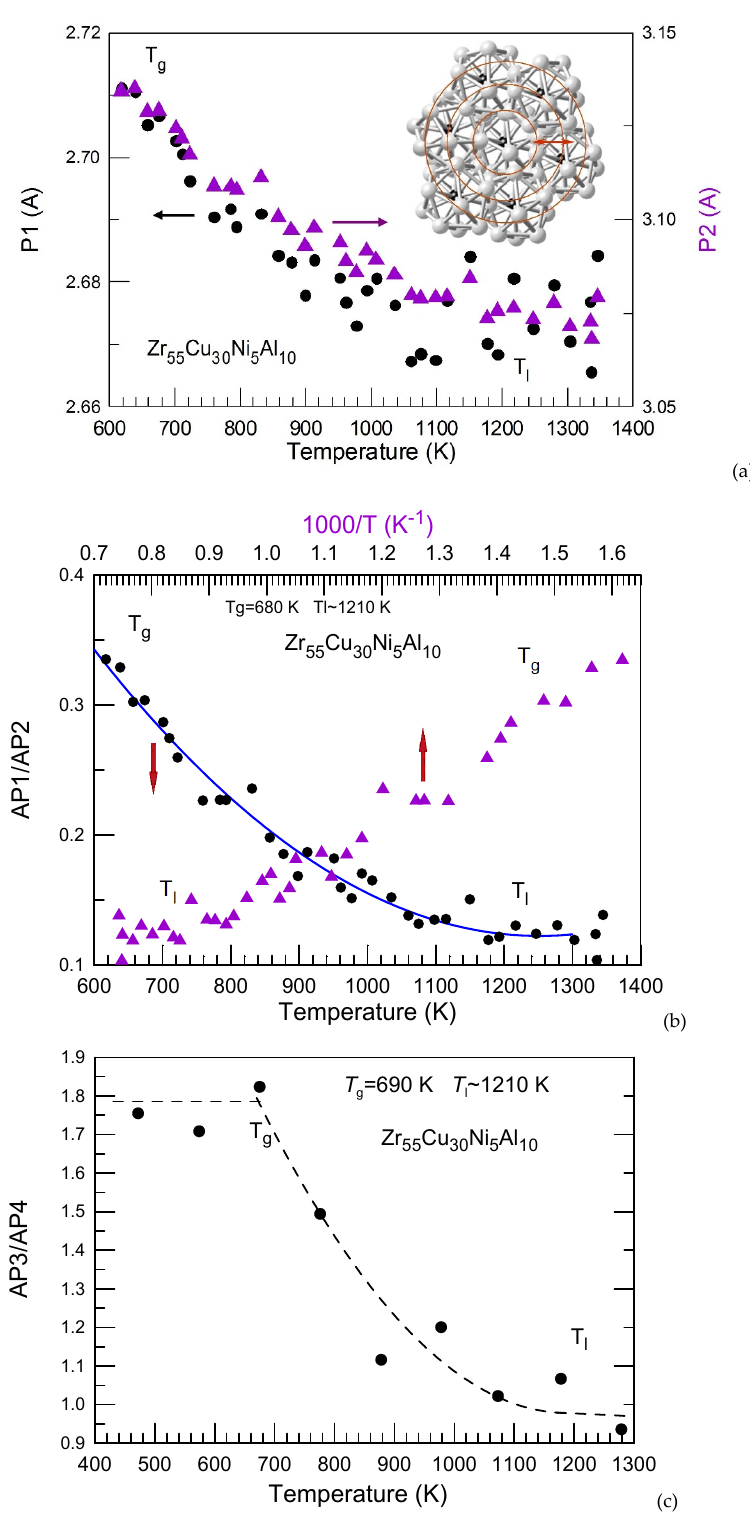
Figure 9. Positions of P1 and P2 in the first coordination shell ( a ) and the ratio of the corresponding peak areas ( AP1/AP2 ) ( b ) as a function of temperature ( a , b ) and inverse temperature in ( b ). The arrows in ( a ) indicate Y-axes corresponding to the data while the arrows in ( b ) indicate the corre- sponding X-axes. The insert in ( a ) is a schematic representation of atomic positions within and be- tween the first and higher order coordination shells indicated by red circles. The plots were repro- duced from Ref. [152] with permission of Elsevier. The area ratios AP 3/ AP 4 as a function of temper- ature ( c ) are calculated from G ( R ) functions from the earlier work [152]. The temperature dependence of the first two sub-peaks intensity ratio in the super- cooled liquid alloy follows variation of viscosity. It suggests that an increased chemical short range order due to formation of the atomic clusters is directly responsible for the rapid non-Arrhenius increase in viscosity of a supercooled liquid upon cooling. Continu- ous structural changes in the supercooled liquid leading to the formation of preferred atomic bonds in the first coordination shell and modification of medium range order both change the activation energy ( E a ) for viscous flow in Equation (2), and thus, cause devia- tion from the Arrhenius temperature dependence of viscosity which in term determines fragility of the glass-forming liquids. As in case of the Pd-Cu-Ni-P alloy [136] AP1/AP2 (the area under P1 divided by the area under P2) ratio changes on cooling in the supercooled liquid state. However, the changes in AP1/AP2 ratio for the Zr 55 Cu 30 Ni 5 Al 10 liquid alloy from T l to T g ( AP1/AP2 = 2.5) are smaller in the absolute values compared to those found in the Pd 40 Cu 30 Ni 10 P 20 liquid alloy for which AP1/AP2 = 4.5 [136]. The AP1/AP2 ratio values normalized per Kelvin ( APR n ) according to the supercooled liquid region on cooling ( T l – T g ) are 0.005 and 0.017 K –1 , respectively, are in line with a lower fragility of the Zr 55 Cu 30 Ni 5 Al 10 melt compared to that of the Pd 40 Cu 30 Ni 10 P 20 one. The difference in the specific heat capacity ( C p ) at T g between the liquid and glassy phases is also used to estimate fragility [161]. Δ C pl–g values (difference between C p of liquid ( C pl ) and glassy ( C pg ) phases) of 10 and 17 J/mol ⋅ K for Zr 55 Cu 30 Ni 5 Al 10 and Pd 42.5 Cu 30 Ni 7.5 P 20 alloys, respectively [152], are also in line with the fragility parameters of these alloys. Metallic glasses exhibiting more fragile supercooled liquid behavior showed a higher degree of density fluctuations probed using synchrotron X-ray nanoscale computed to- mography [138,162]. It was also proposed that there is a link between steepness of the repulsive part of the interatomic potential (derived from the shape of PDF ( R )) and rate at which shear modulus decreases with temperature [163]. This mechanism is suggested to control the temperature dependence of viscosity and can lead to fragile behavior of liquids